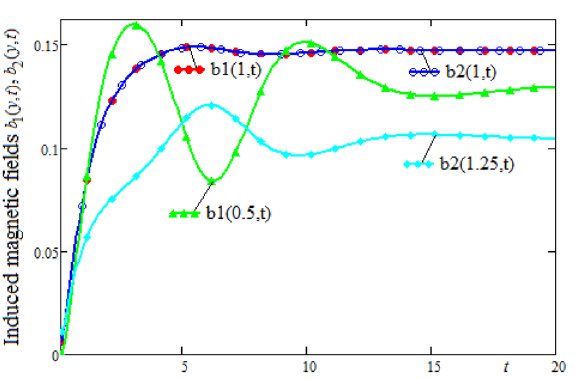
Figure 5. Time-evolution of induced magnetic fields b 1 ( y , t ) , b 2 ( y , t ) in three different positions of